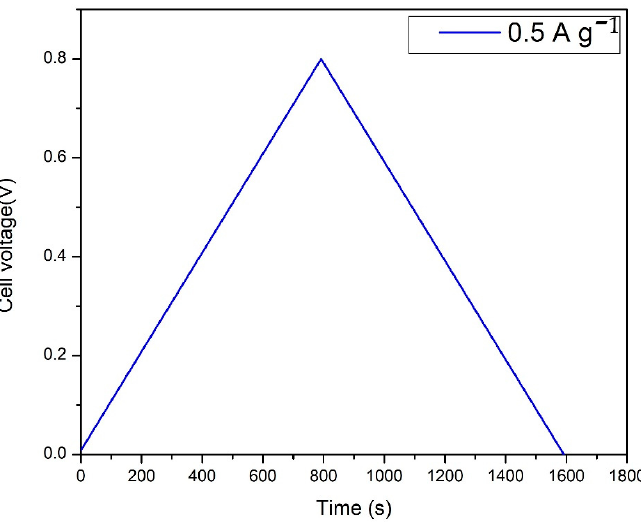
Figure 12. Charge–discharge curve for EDLC with the optimized blend polymer electrolyte at a current density of 0.5 A g − 1 and at 25 ◦ fixed current density of 0.5 A g − 1 and at 25 °C. -